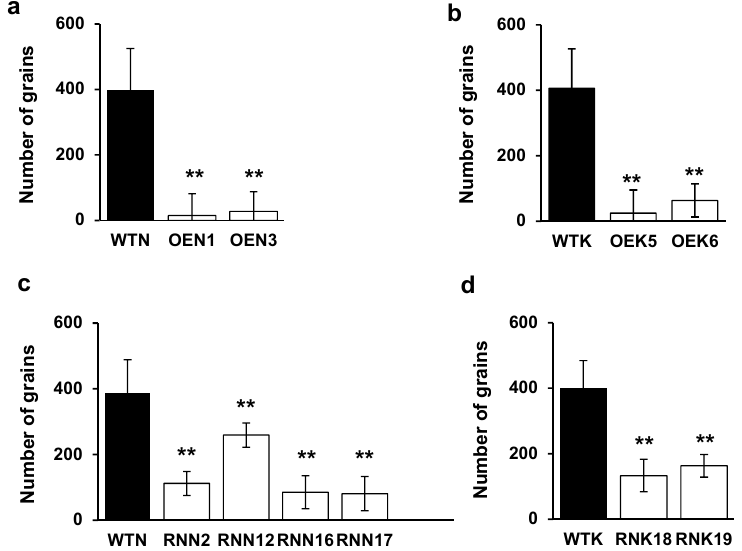
Figure 8. Number of grains in wild-type, OE, and RNAi transgenic lines. Three progenies obtained from the individual transgenic lines were sown and allowed to reach maturity. Matured grains from individual plants were harvested and total grain number was counted. Mean values of grain number from triplicate samples are shown (Student’s t -test, ** p < 0.01). OE lines of Nipponbare ( a ); Kinmaze ( b ); RNAi lines of Nipponbare ( c ); Kinmaze ( d ). Names of plant lines are shown in Figure 4.